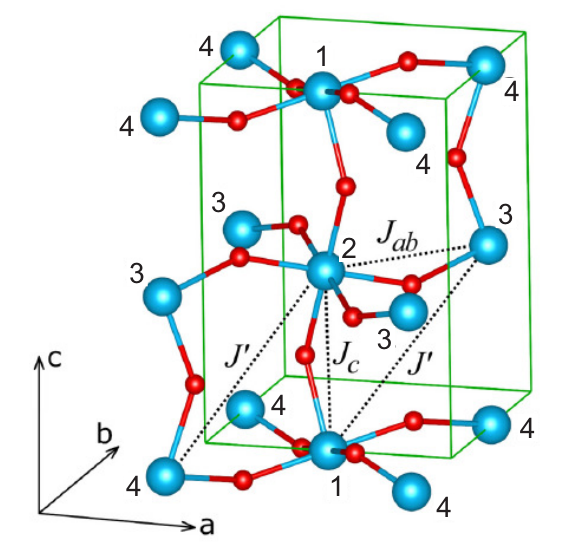
Figure 1. (Color online) Structure of the Fe 3 + –O 2 − –Fe 3 + superexchange bonding in orthoferrites. J ab and J c are nearest-neighbor superexchange integrals; J (cid:48) is the superexchange integral for next- nearest-neighbors. 1, 2, 3, 4, are Fe 3 + ions in four nonequivalent positions. Reproduced from Ref.[9].